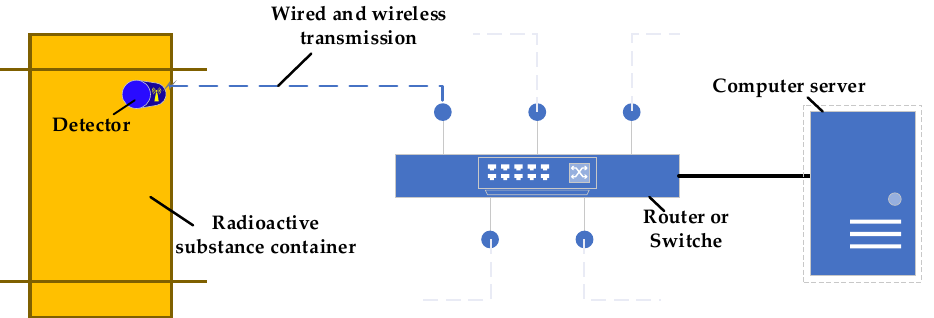
Figure 9. Schematic of the proposed surface radiation detection system for radioactive materials.